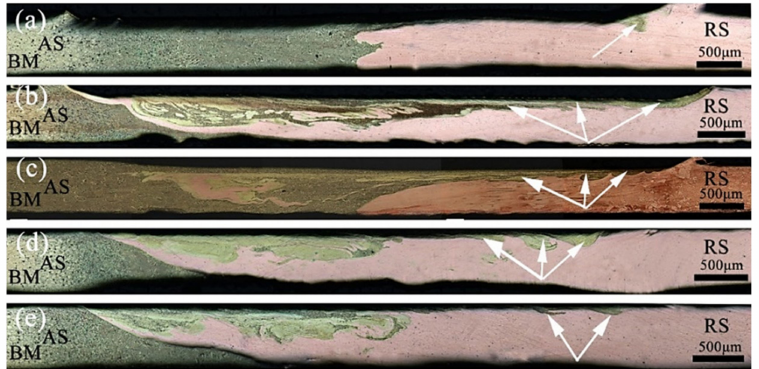
Figure 4. Micromorphology of H62 / T2 joints at di ff erent welding speeds of 12,000 rpm: ( a ) 320 mm /